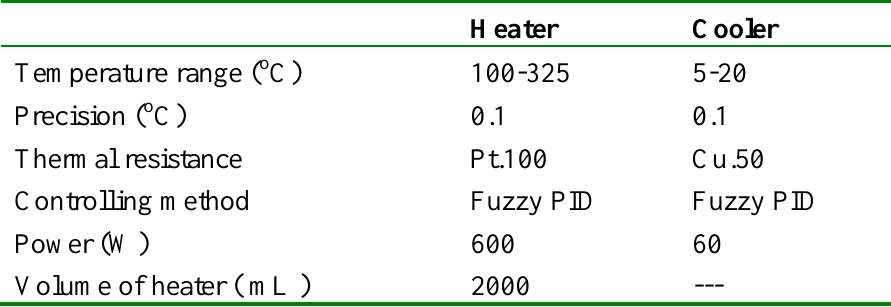
Table 1. The parameter of heater and cooler.